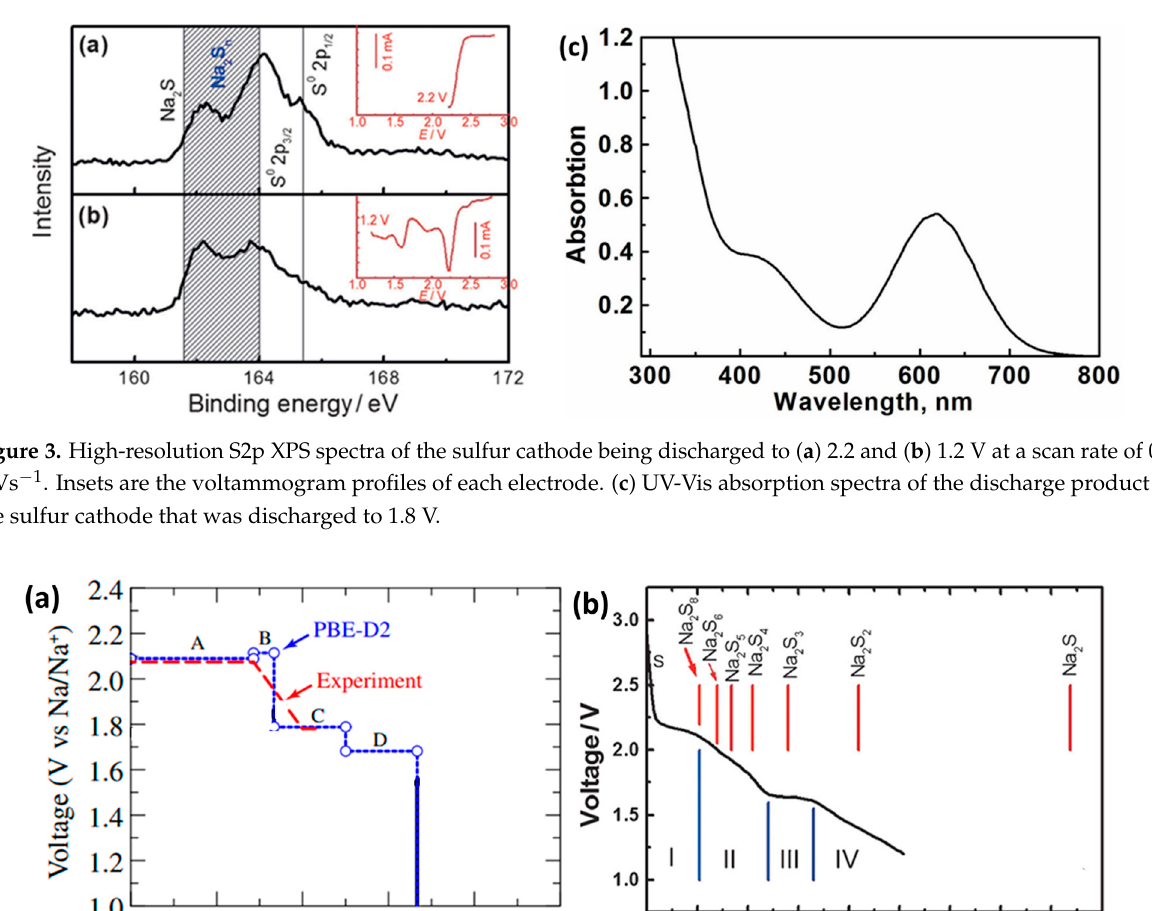
Figure 3. High-resolution S2p XPS spectra of the sulfur cathode being discharged to ( a ) 2.2 and ( b ) 1.2 V at a scan rate of 0.1 mVs -1 . Insets are the voltammogram profiles of each electrode. ( c ) UV-Vis absorption spectra of the discharge product of the sulfur cathode that was discharged to 1.8 V.